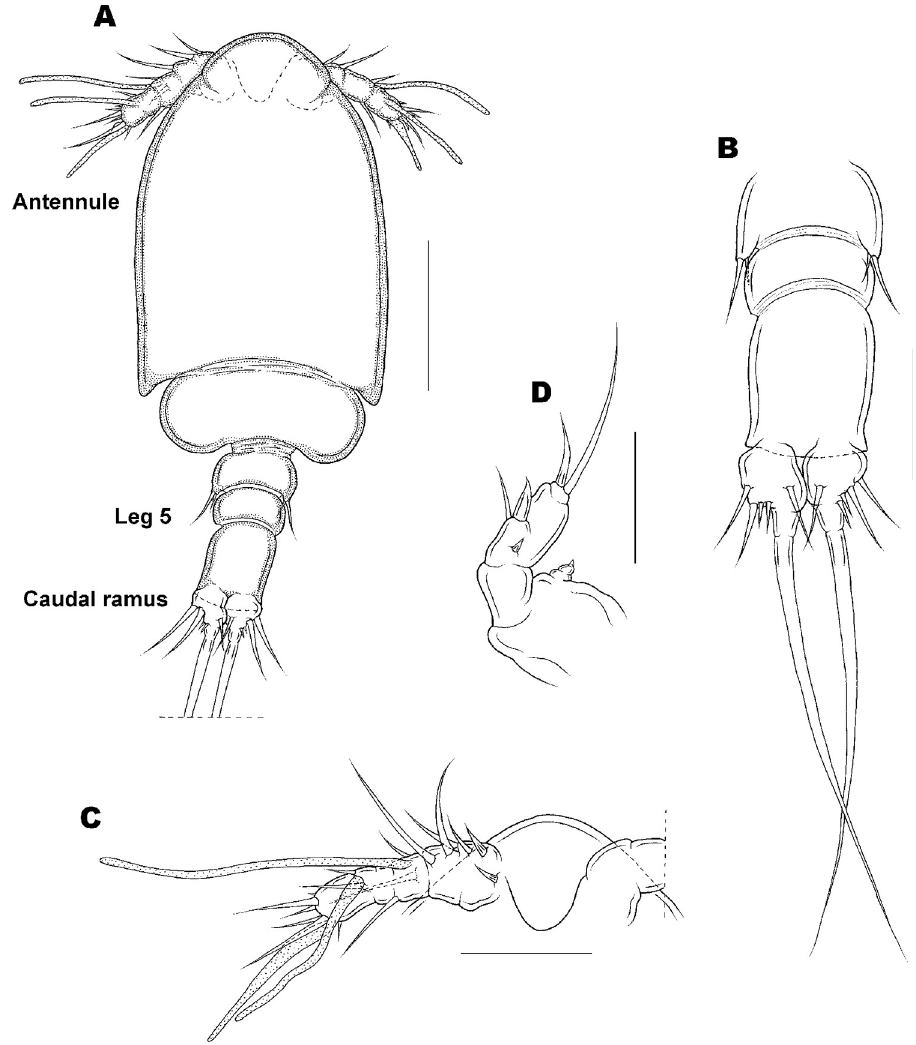
Fig 7. Copepodid stage II of Ive ptychoderae . (A) Habitus, dorsal; (B) Urosome, dorsal; (C) Antennule; (D) Antenna; Scale bars: A = 0.05 mm; B–D = 0.025 mm. Antennule (Fig 9C) short, unsegmented, divisible into 3 parts: proximal part carrying 2 unequal setae; middle part armed with 1 large and 2 small setae; distal region with 3 small tubercles. Antenna (Fig 9D) 3-segmented, first and second segments unarmed; third segment with 1 large claw and 1 pointed process. Labrum (Fig 9E) projected posteriorly at both free corners. Mandible, maxillule, and maxil- liped not present. Legs 1 and 2 as in adult (Fig 9F and 9G; see [32]). Legs 3–5 absent. Adult The adult I . ptychoderae is vermiform, without external segmentation, lacking typical mor- phological features (such as mandible, maxillule, maxilla, maxilliped, and legs 3–5), resulting in simplification of body plan. The female is characterized by having five pairs of annular swellings along the body that are morphologically similar but distinguishable from its conge- ners in acorn worms [32]. More detailed descriptions of the adult morphology of I . ptycho- derae were reported previously [32], and thus will not be repeated in the paper.